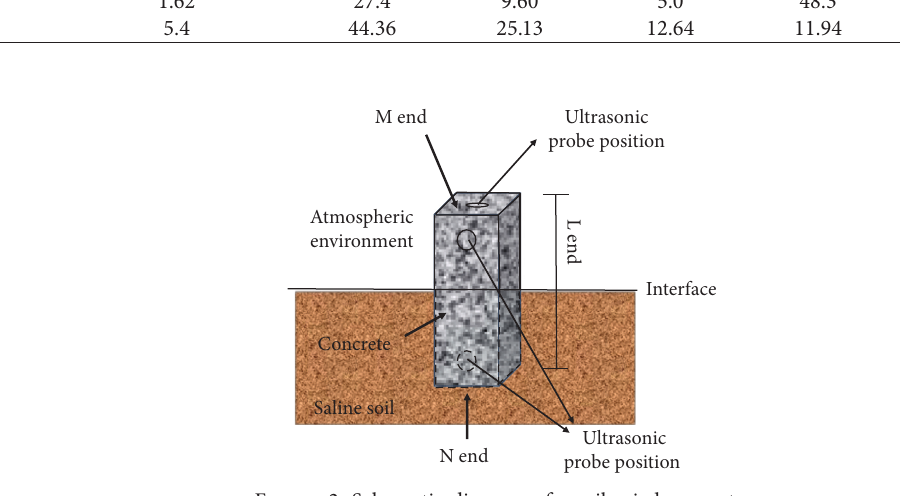
Figure 2: Schematic diagram of semiburied